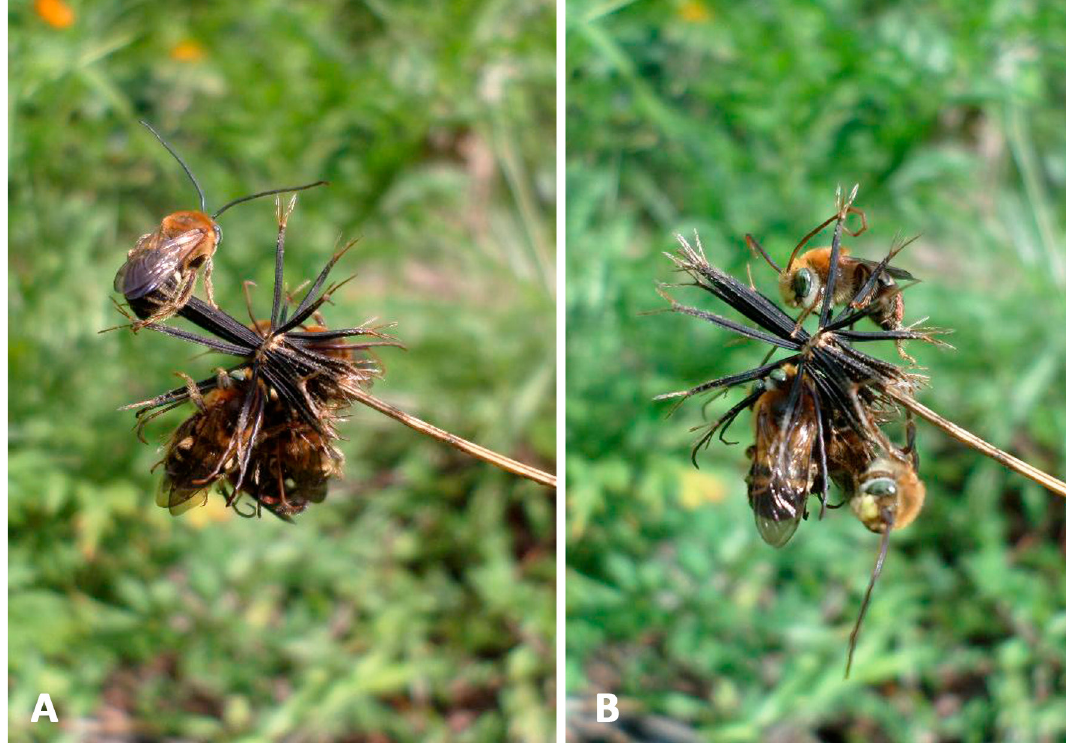
Fig 1. Male sleeping aggregation on dried inflorescence of Bidens pilosa 60 cm above the ground (A) Melissodes nigroaenea males arriving at the sleeping aggregation. (B) M. nigroaenea males trying to find a position in the sleeping aggregation.